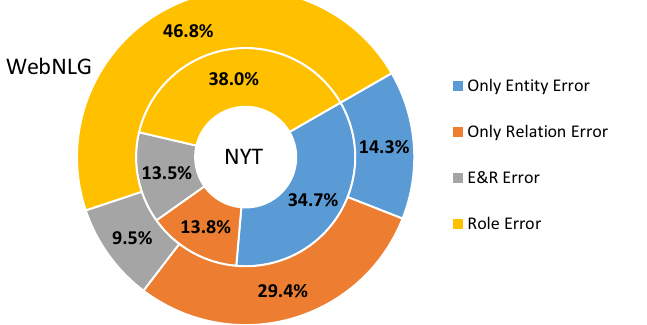
Figure 2. Comparison of triple prediction error